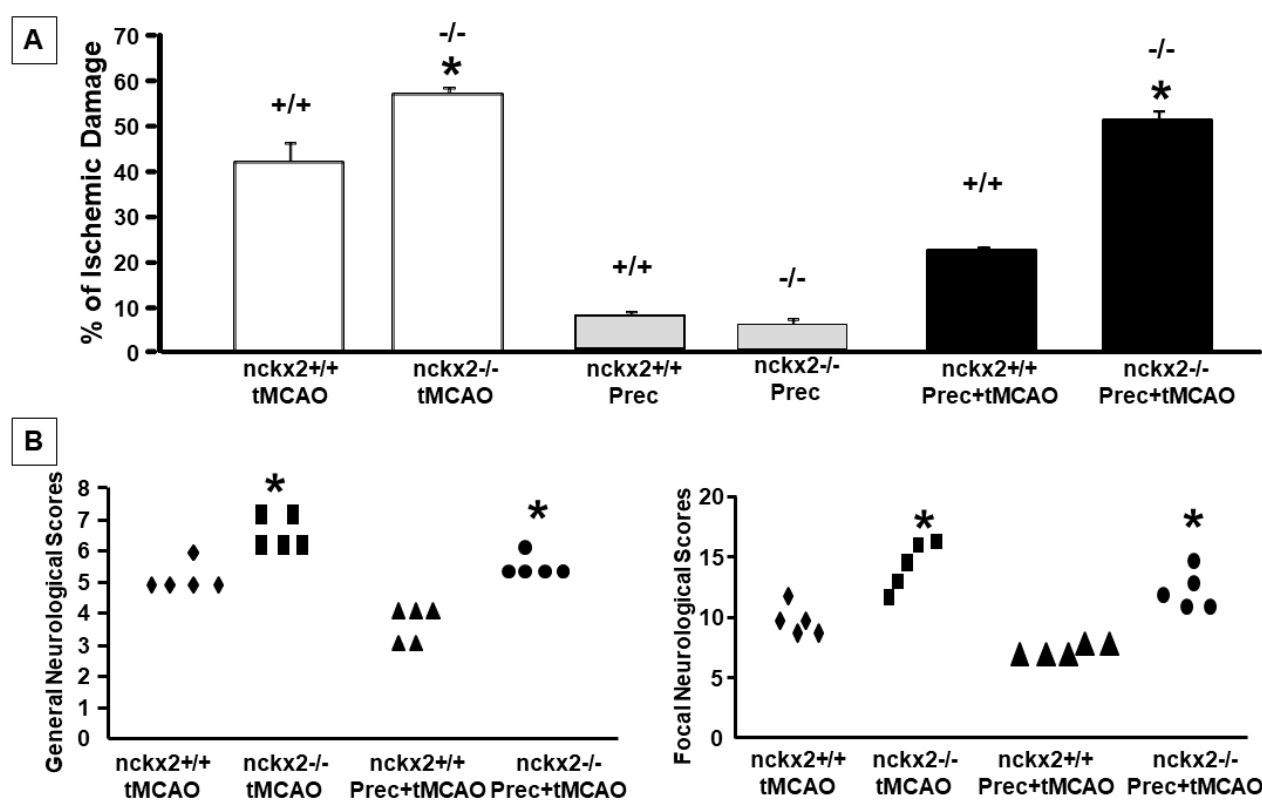
Figure 6. EFFECT OF NCKX2 KNOCKING-OUT ON THE NEUROPROTECTION MEDIATED BY PRECONDITIONING. ( A ) Percentage of the Ischemic Damage in nckx2+/+ and nckx2 − / − mice subjected to tMCAO, preconditioning or preconditioning + tMCAO. Mice were euthanized 24 h after surgery. * p < 0.05 versus tMCAO group. ( B ) General and Focal Neurological scores in nckx2+/+ and nckx2 − / − mice subjected to tMCAO or tMCAO + preconditioning. Neurological function was assessed 24 h after surgery. * p < 0.05 versus tMCAO group.